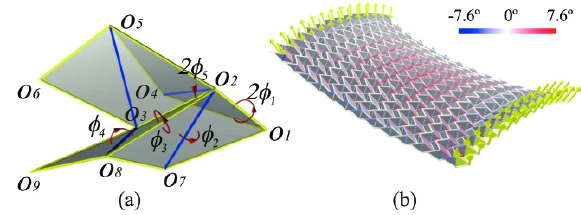
Figure 21: Increased structural stiffness of the folded edges (com- pared to the same material in the flat form) in the Miura origami pattern [28]